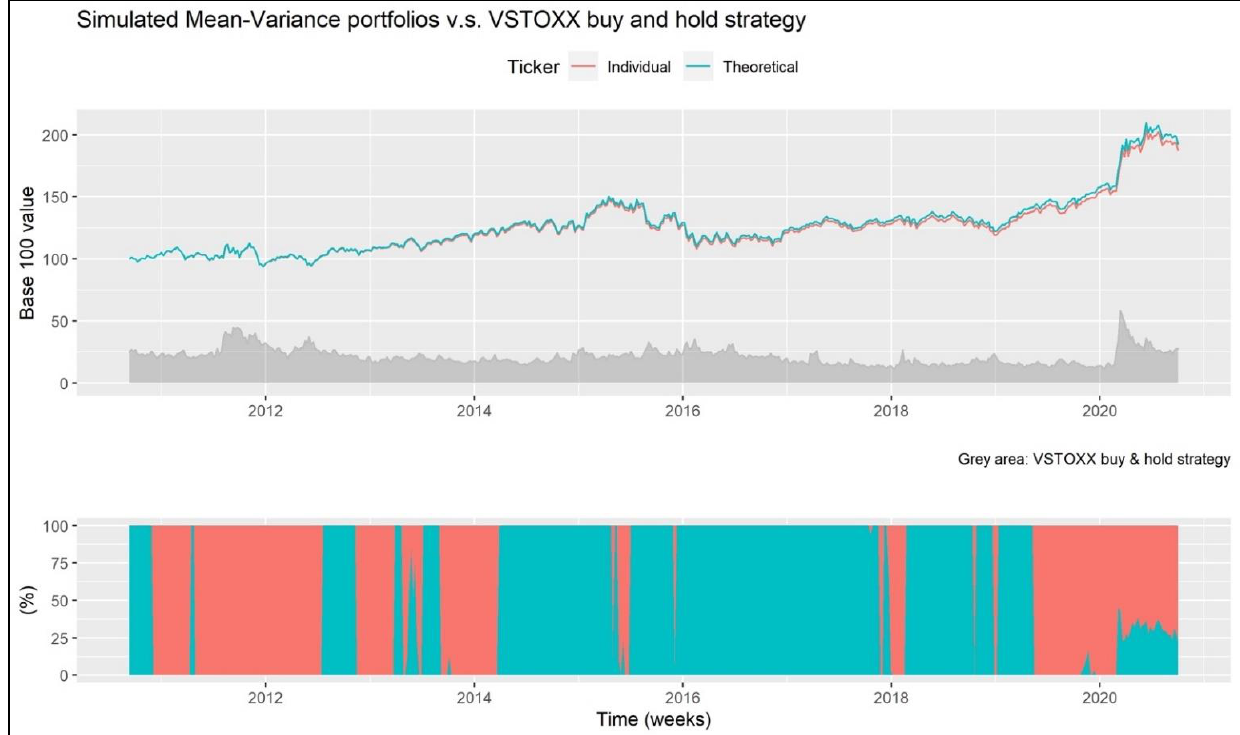
Figure 9. Weekly historical values of an individual investor that optimally selects two ETFs. One invested in the ESTOXX50 and another in portfolio 1 of the institutional simulated investor (Figure 7). Comparison against the VSTOXX index.